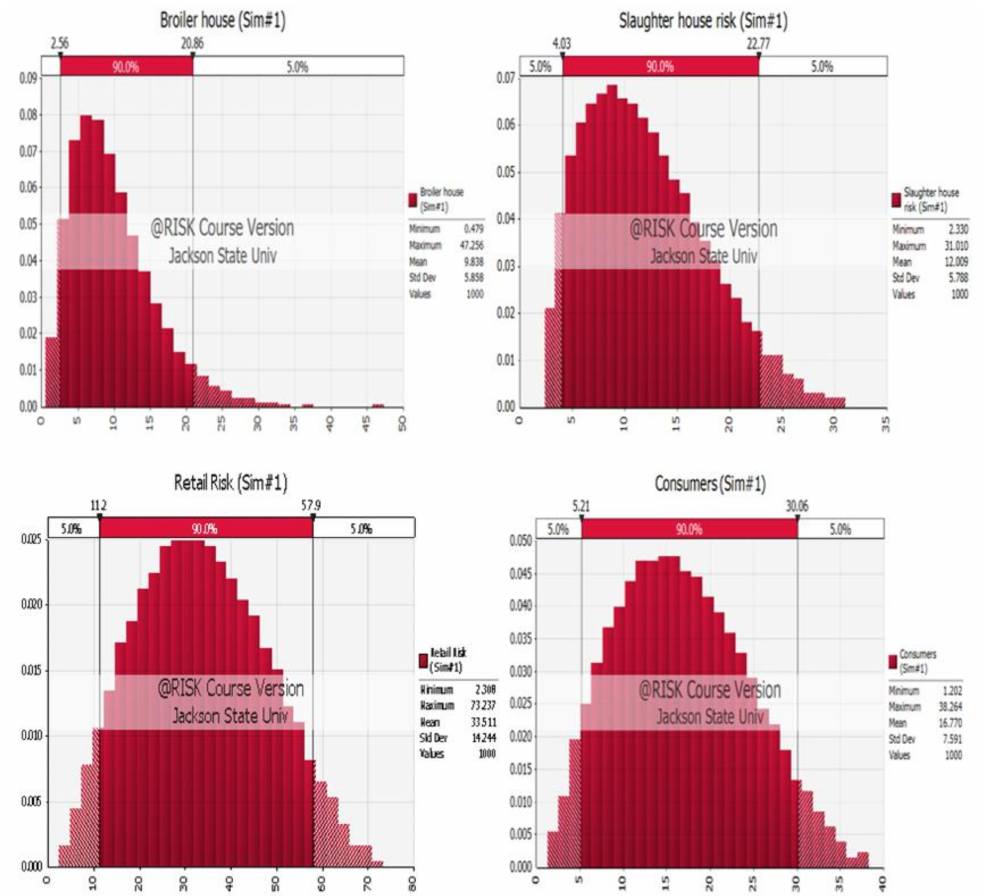
Figure 2. Simulation models for the four nodes of the Quantitative Risk Assessment Model (QRAM): broiler house, slaughter house, retail and